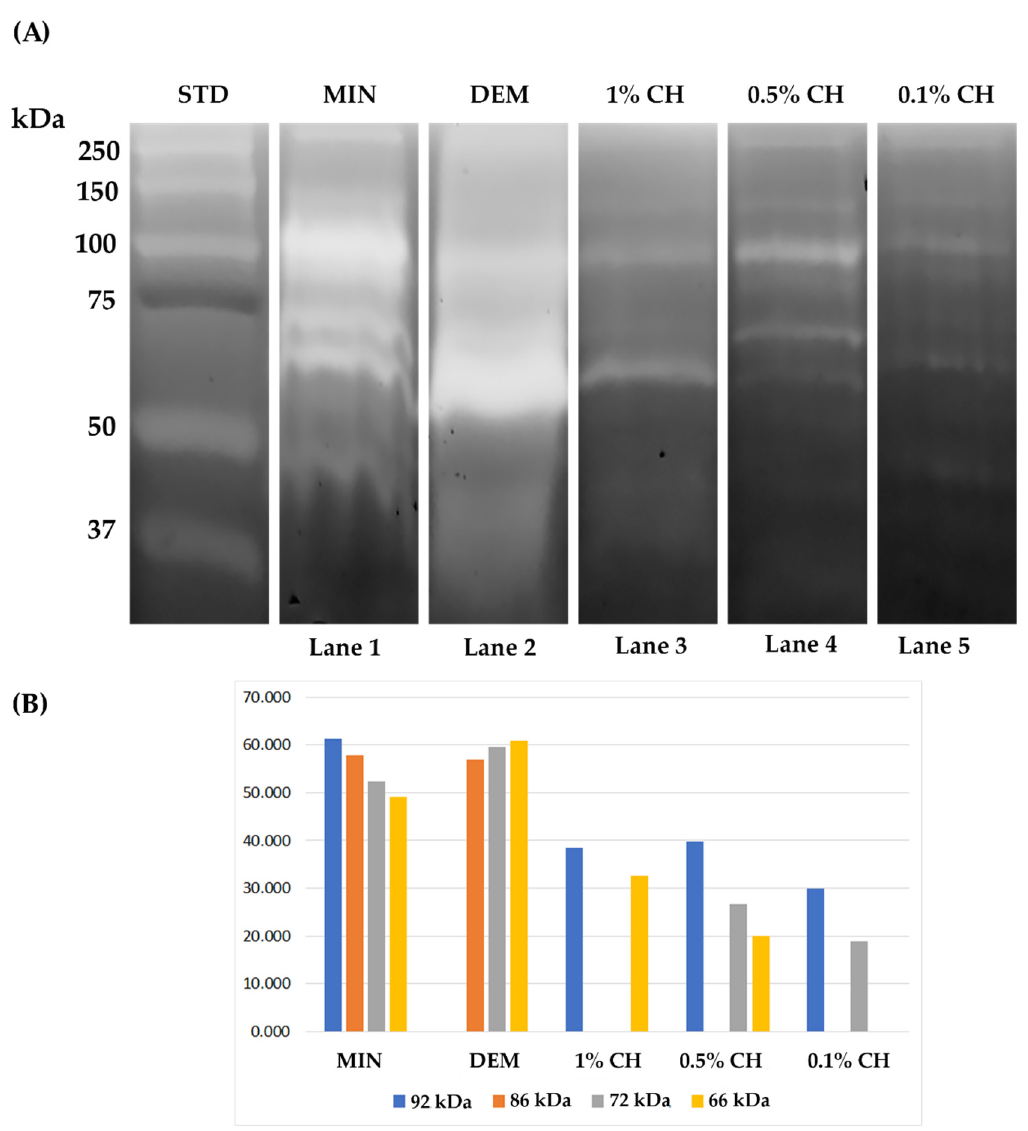
Figure 1. Zymographic analysis of proteins extracted from dentin powder. ( A ) Figure showing the differences in the enzymatic expression and activity between the investigated groups presented as light bands in the area of the molecular weights of MMP-2 and MMP-9. ( B ) Densitometric evaluation of the bands in the different treatment groups.